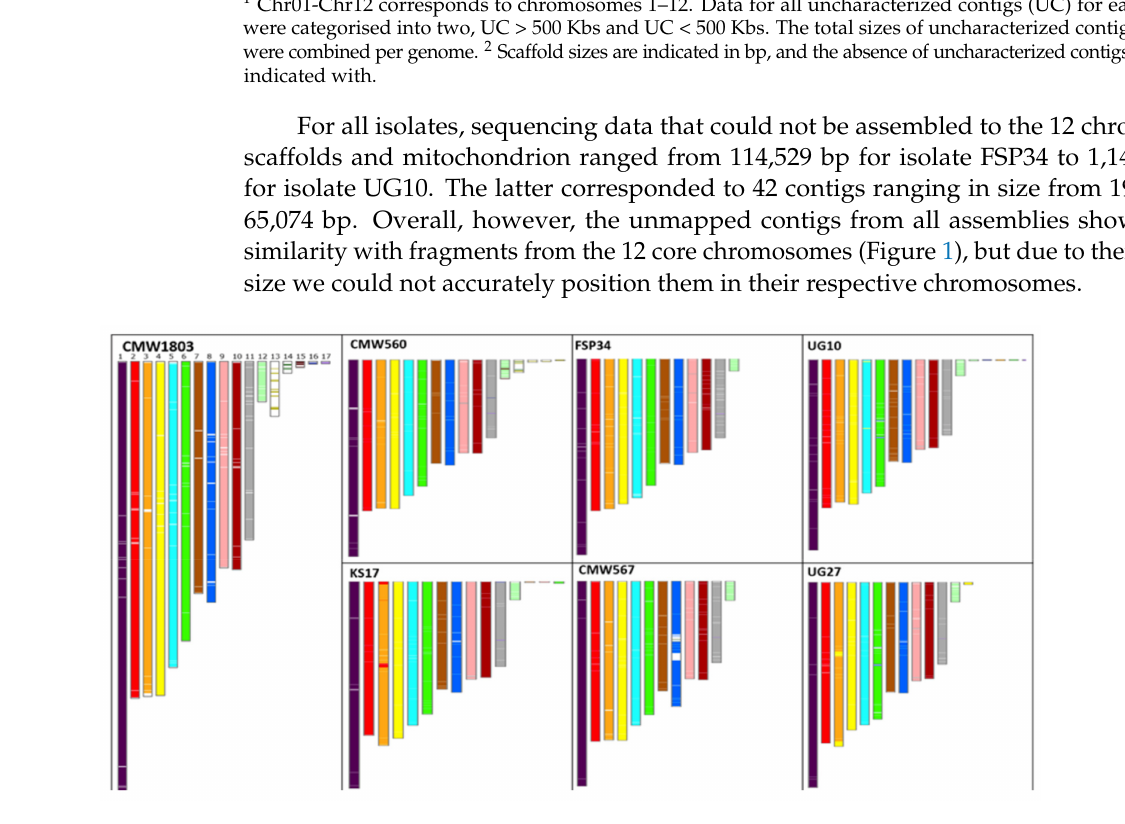
Figure 1. SynChro [64] generated chromosome painting, comparison of the isolates showing the uncharacterized scaffold > 500 Kbs in CMWF1803 and CMWF560. No similar sequences were found in the other